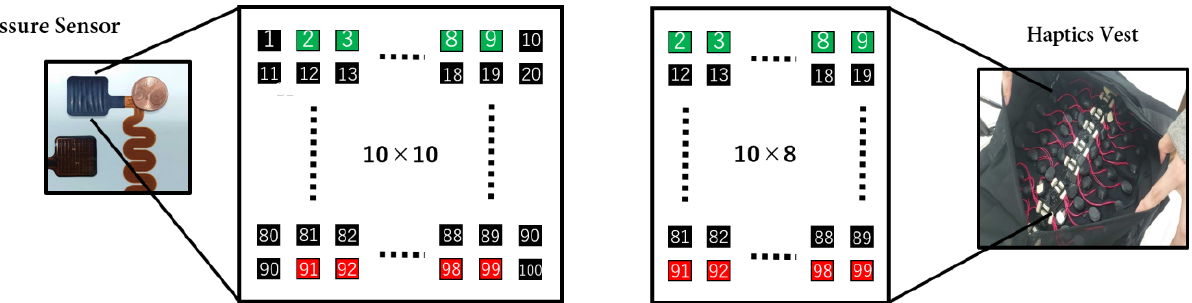
Figure 7. Correspondence between the pressure sensor and the haptics voice coil type vibrators (Pressure sensor and voice coil type vibrator have a spatial one-to-one correspondence. The pressure sensor reads the tactile sensation as a 10 × 10 matrix. Since the 10 × 8 matrix is enough to achieve one-to-one spatial correspondence with the vibrator array, the data of columns at both ends of the pressure sensor matrix are ignored).